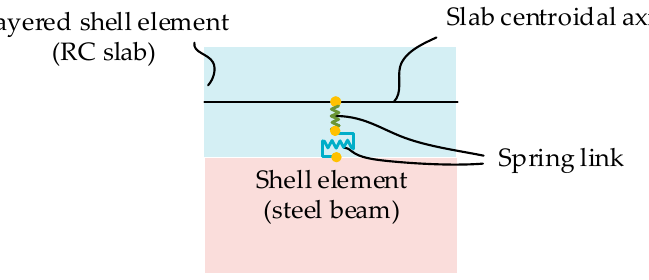
Figure 5. Simulation of the shear connector in the finite element model.